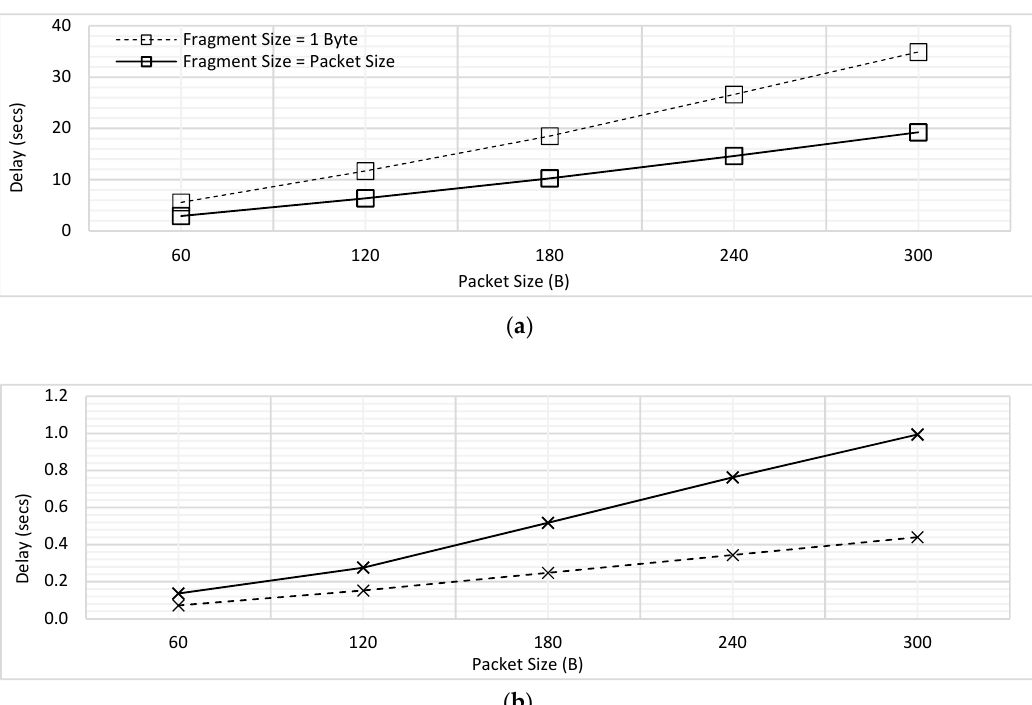
Figure 12. Comparing the Influence of Fragmentation on Delay ( a ) Low Priority Traffic ( b ) High Priority Traffic.